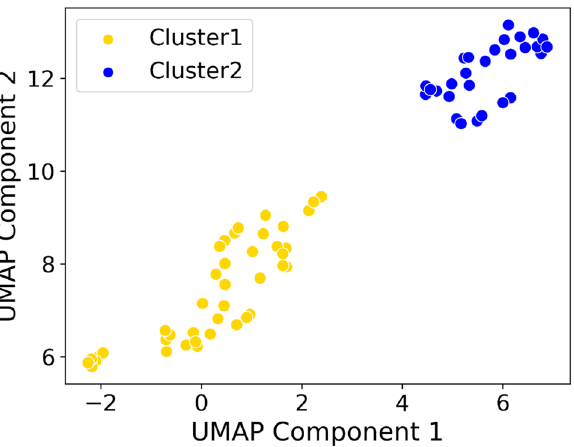
Figure 2. Uniform Manifold Approximation and Projection (UMAP) of component 1 versus component 2 showing two clusters (Cluster 1 = gold, n = 41; Cluster 2 = blue, n = 28) of participants with differentially expressed cytokines identified by spectral